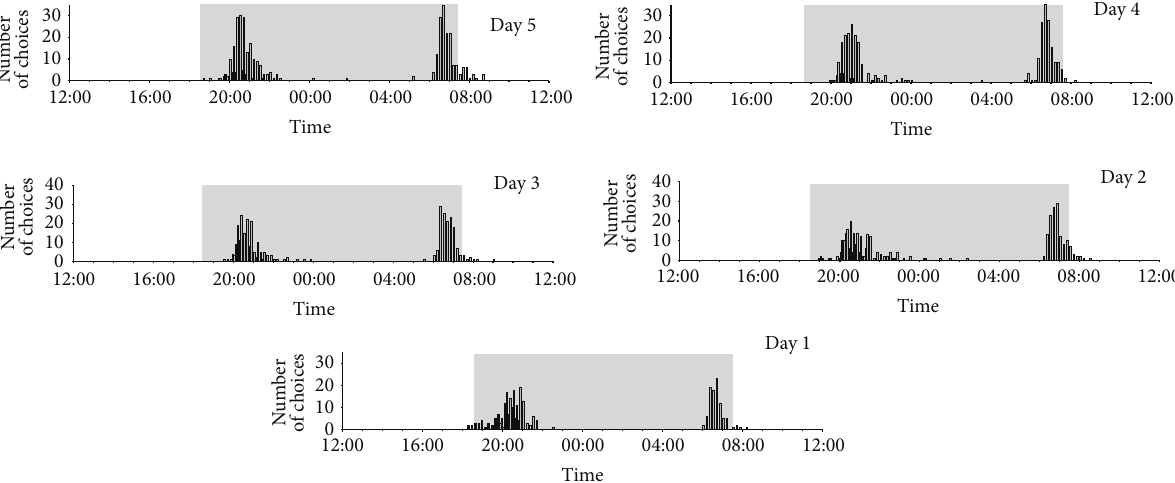
Figure 3: Activity patterns of caterpillars in a laboratory colony recorded over five consecutive days. The 𝑥 -axis records the number of choices over five-minute intervals for the old site (dark bars) and the new site (hollow bars). Scotophase indicated by shaded area.